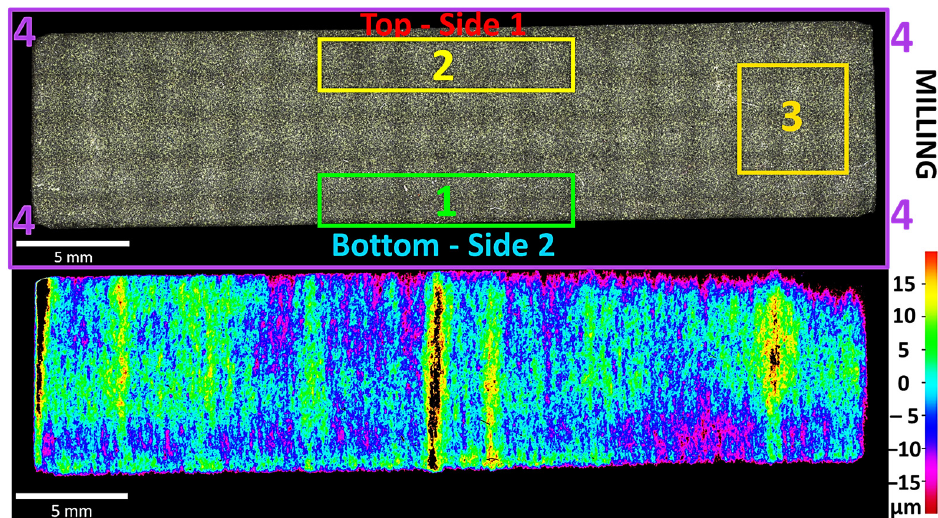
Figure 9. Qualitative analysis of roughness profile and topographic mapping for height variation after controlled milling.